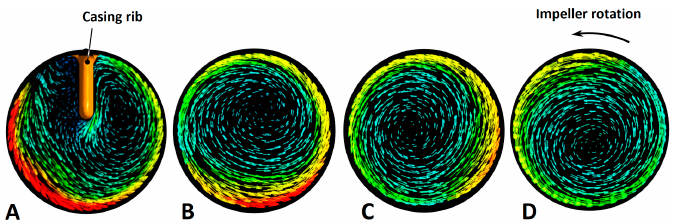
Figure 7. Comparison of vector maps from the numeric model (Ansys, setting 1) and the experiment (PIV). As the flowrate decreases (point P4), the mean velocity in the pipe also decreases. Due to impeller rotation and viscosity, the fluid accelerates in the middle part of the cross-section, immediately before the pump inlet. Further reduction in the flowrate leads to the formation of local vortices in the pipe and recirculation of the liquid at the pump inlet [2]. This fact is also indicated by the images of radial flow cross-sections created in Ansys for point P5 (see Figure 8), where significantly higher flow velocities can be observed near the sides compared to the middle part of the pipe. However, a 3D PIV measurement would be needed to accurately de- scribe the vortex formation because the particles in this part of the pipe move generally in space and thus outside the monitored plane, which is not captured by the 2D PIV method.